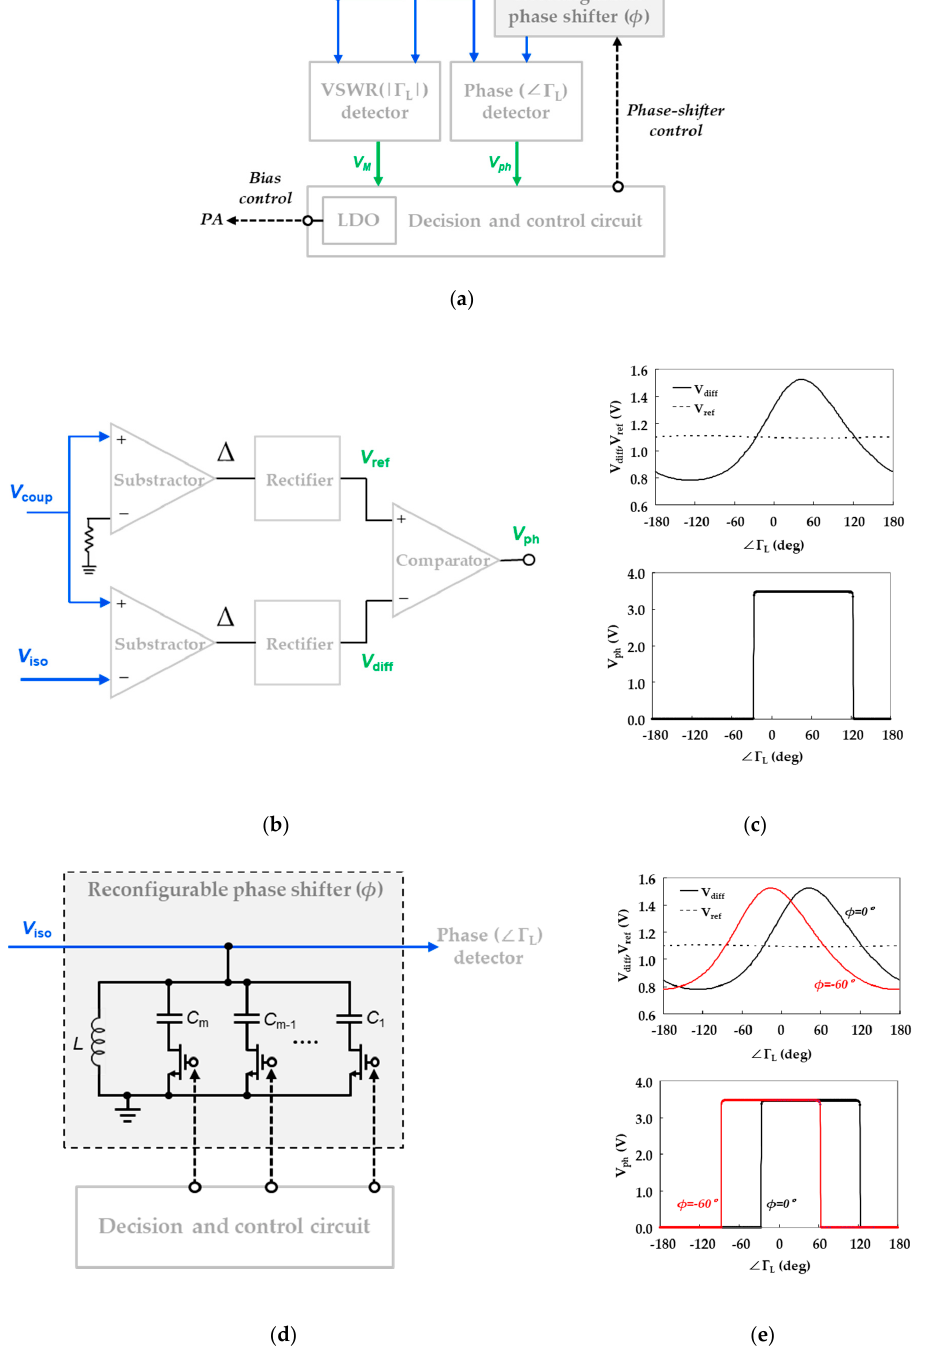
Figure 4. ( a ) Proposed mismatch impedance detector; ( b ) block diagram of phase detector; ( c ) simulated V diff , V ref and V ph ; ( d ) reconfigurable phase shifter configuration; ( e ) simulated V diff , V ref and V ph for two phase values of phase shifter.